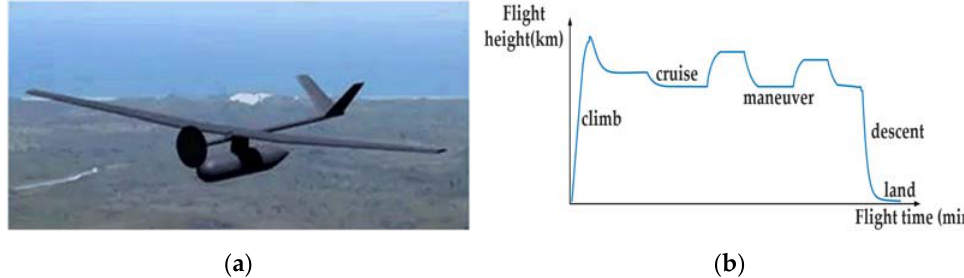
Figure 1. UAV and mission profile. ( a ) The effect drawing of the studied UAV, ( b ) the mission profile for UAV.